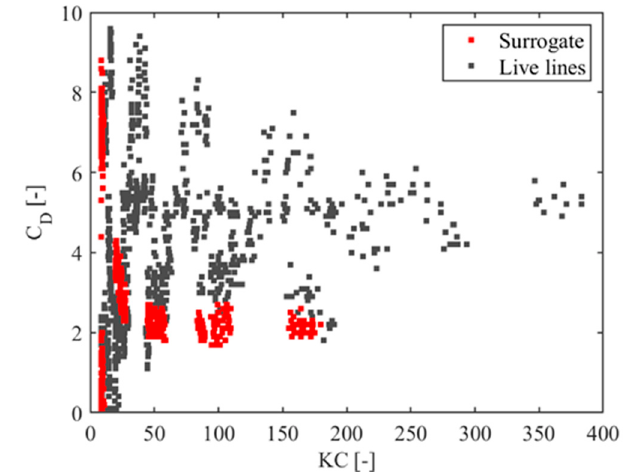
Figure 11. Drag coefficients related to the Keulegan–Carpenter ( KC ) number for the live lines and the surrogate. The mean RMSE (Equation (3)) of the measured and MOJS approximated force peaks, using the experimentally determined drag coefficients, are listed exemplarily for line 3 and the surrogate in Table 5. RMSE decreases from wave train 1 to wave train 13 for all lines; RMSE of force peaks of wave train 1 is 3.1 to 9.5 times higher than the RMSE of force peaks due to wave train 13. Examples of the force time history of the smallest and highest wave trains in these experiments are depicted for the dropper line 3 in Figure 12. RMSE for the force peaks of wave train 1 is 85.7% and 13% for wave train 13. There is no signifi- cant difference between mean RMSE of the live mussel dropper lines and the surrogate with 33.3% and 24.6%, respectively. Table 5. Mean root mean square error (RMSE) of measured and MOJS approximated force peaks of total force in x-direc- tion for Line 3 and surrogate for all wave trains. Wave Train